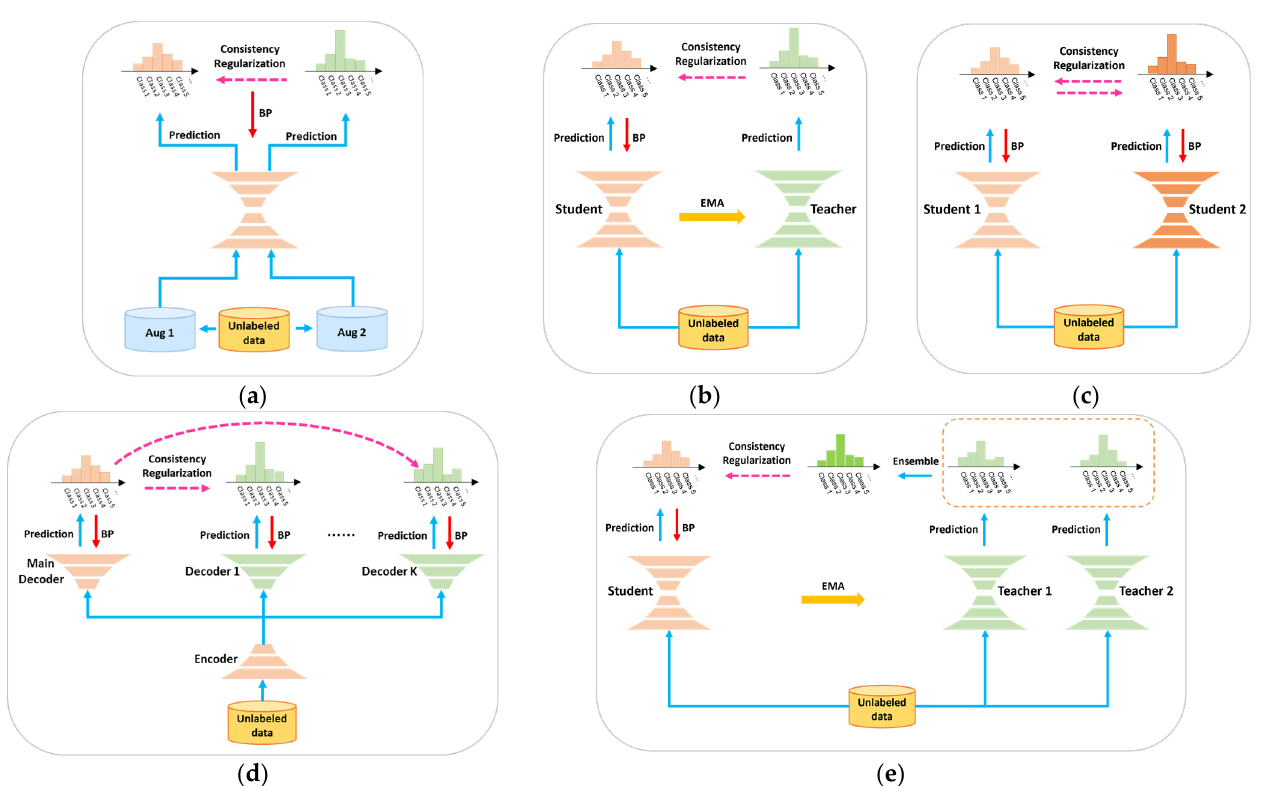
Figure 2. Illustration of several typical consistency regularization-based SSL frameworks. BP means the backpropagation; EMA is the exponential moving average; Aug indicates data augmentation. ( a ) Π -model, ( b ) mean teacher ( c ) dual students, ( d ) cross-consistency training, and ( e ) adopted dual